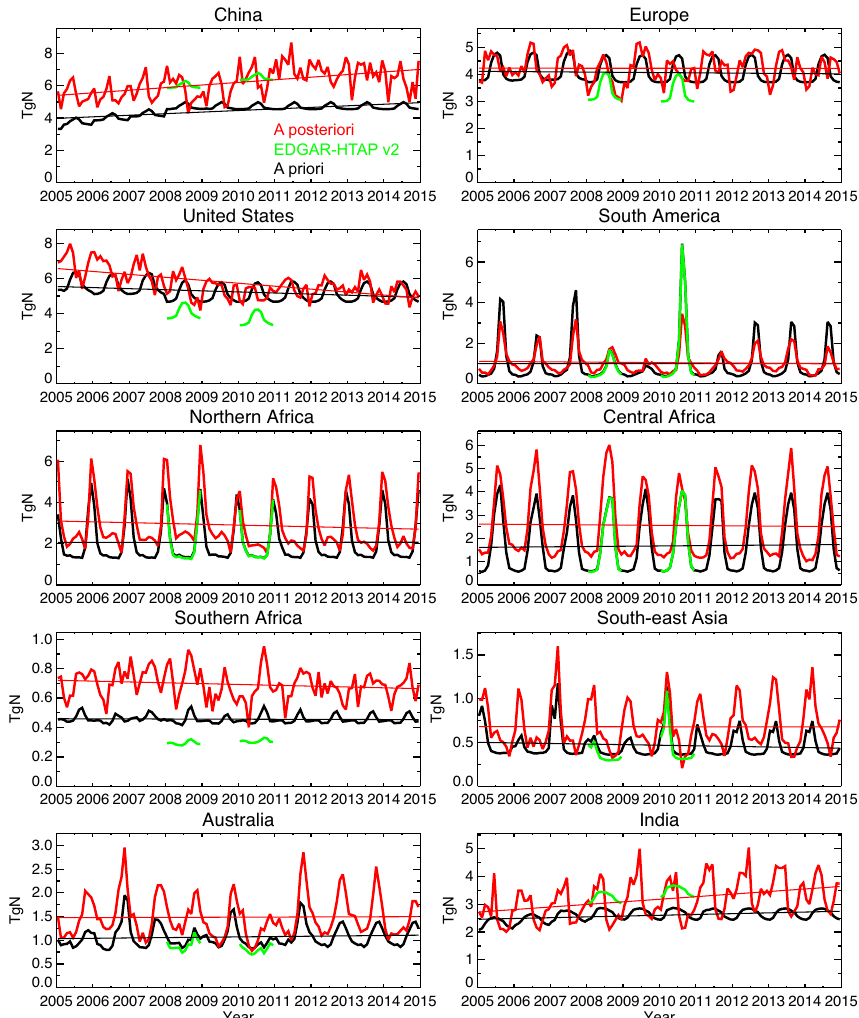
Figure 7. Time series of monthly total regional surface NO x emissions (in TgNyr − 1 ) obtained from the a priori emissions (black lines) and the a posteriori emissions (red lines) for the period 2005–2014. The results are also shown for EDGAR-HTAP v2 emissions (green lines) for the years 2008 and